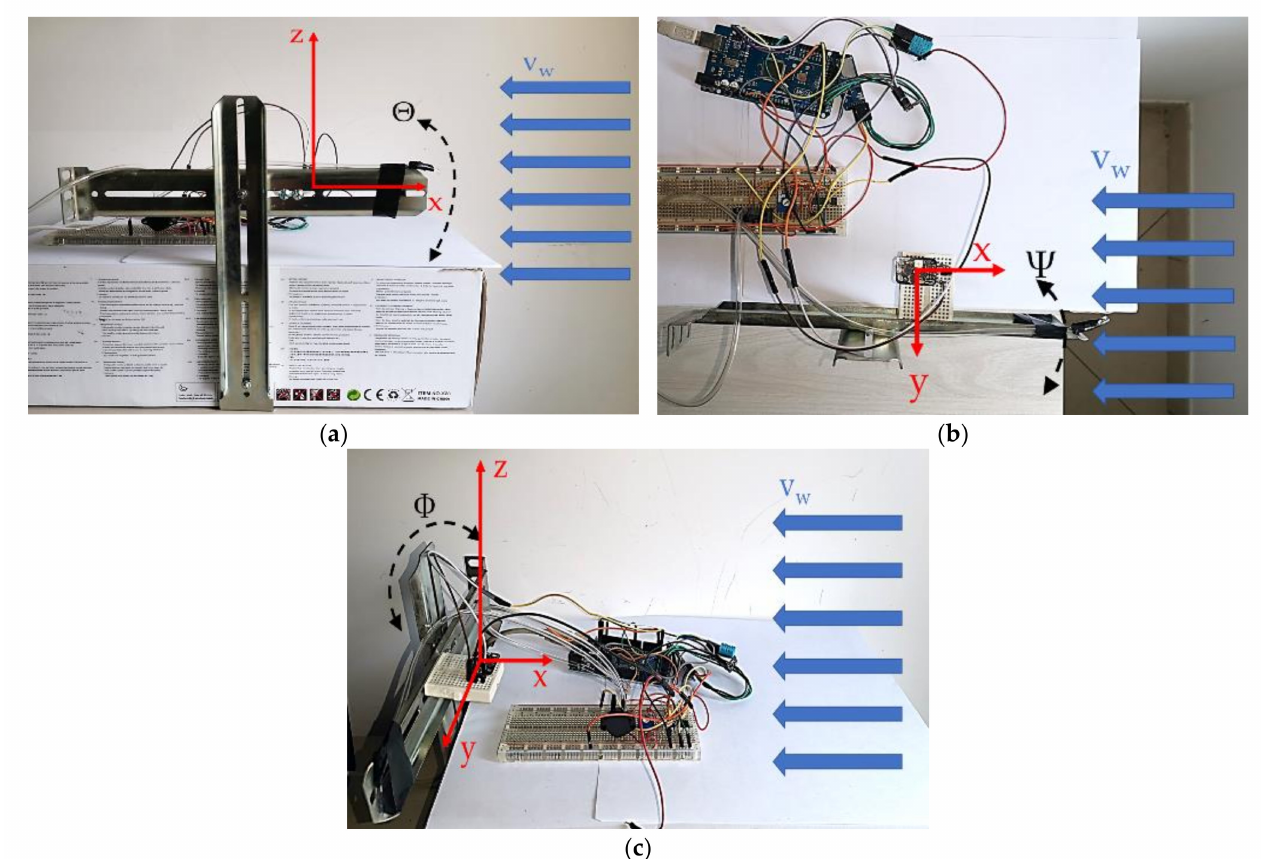
Figure 13. The prototype mounted on a movable structure to simulate pitch ( a ), yaw ( b ), and roll ( c ) variations.